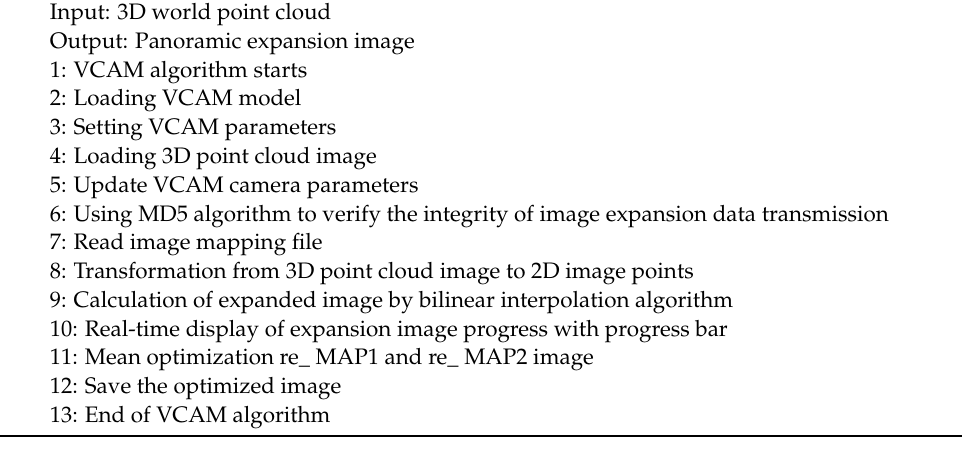
Algorithm 3 Image transformation from 3D world point cloud to panoramic